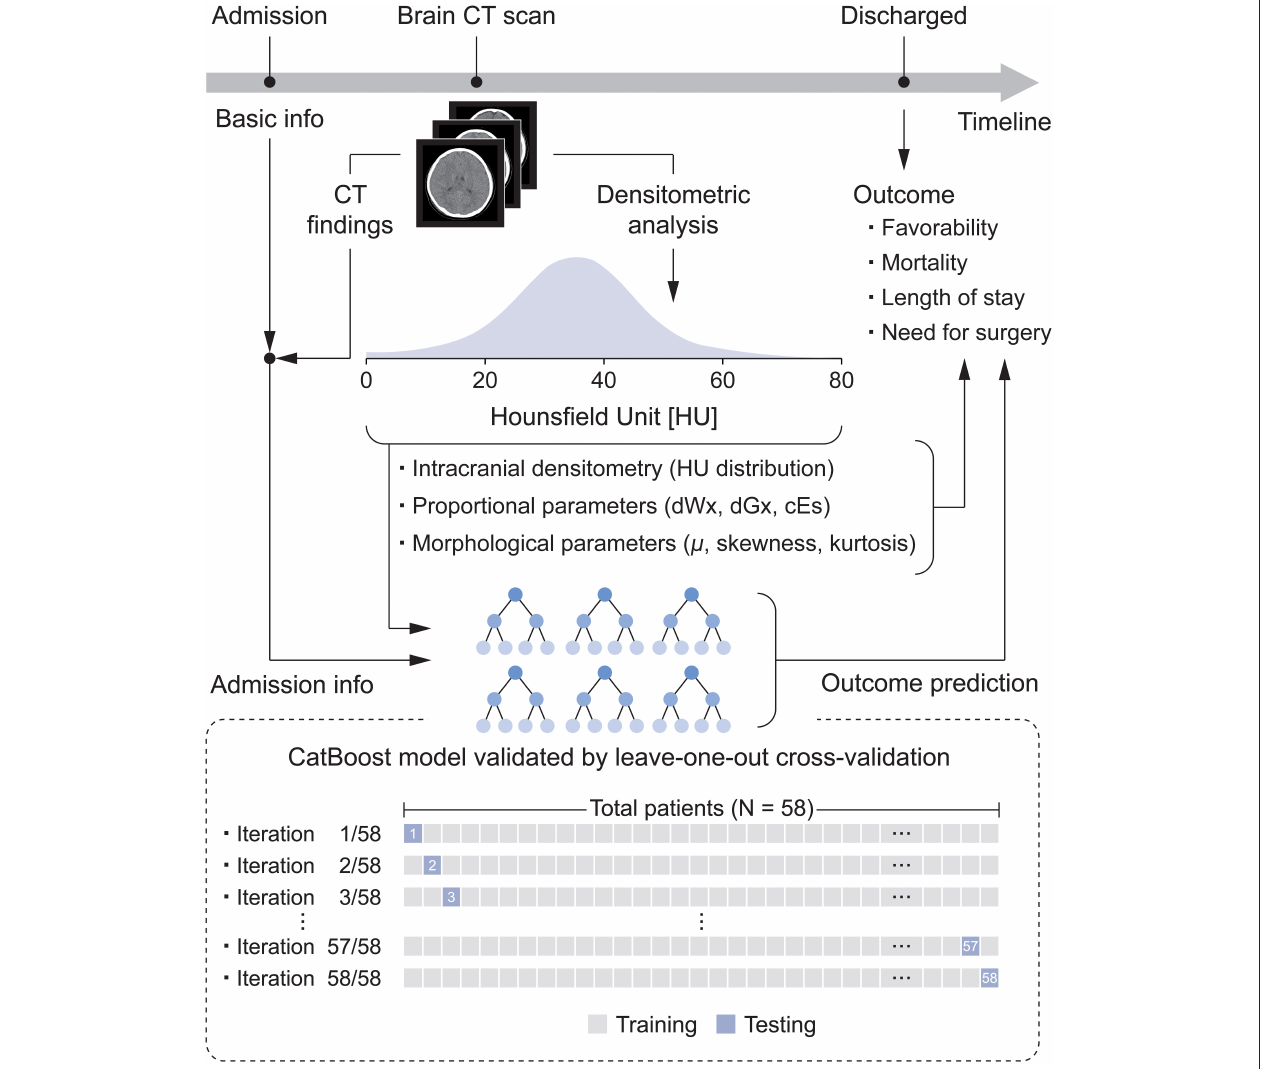
FIGURE 1 | Flow diagram for the development of the densitometry-augmented prognostic model based on brain CT.